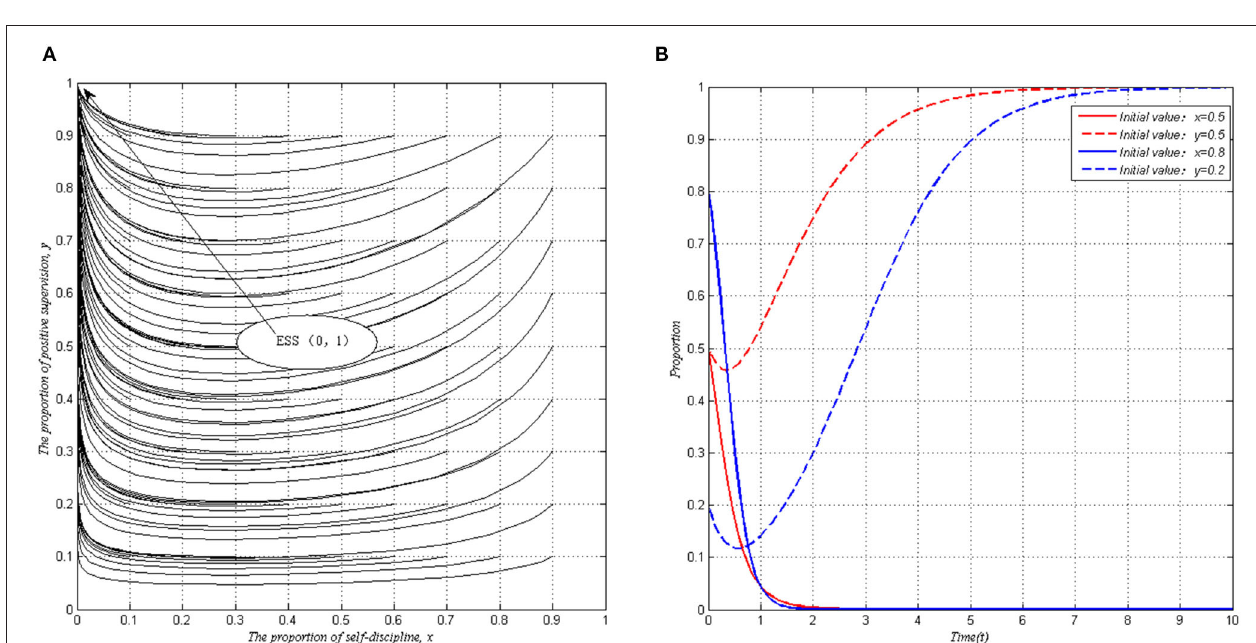
1, P 1.5, I 2, C 1, 1 L 4). (A) Arbitrary proportion. (B) Specific proportion. = = = = =